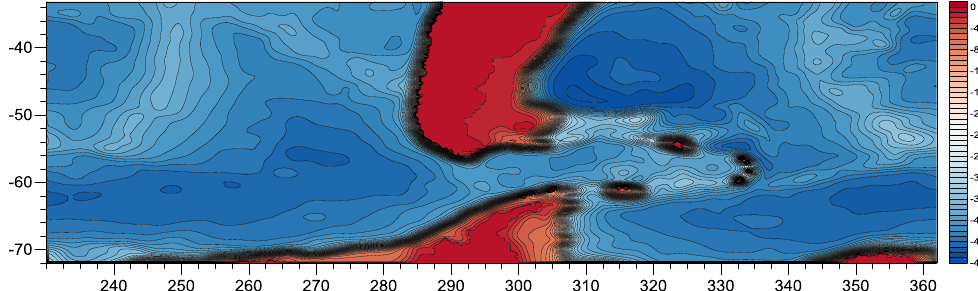
Fig. 2. Domain of integration and bottom topography (in